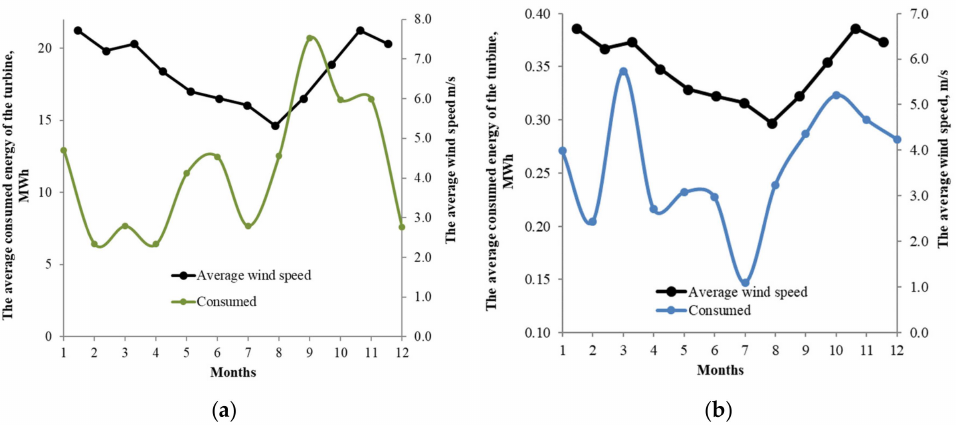
Figure 6. The relationship between the average consumed energy by wind turbines / farms and the average wind speed: ( a ) in > 10 MW capacity of the wind turbines; ( b ) in < 10 MW capacity of the wind turbines.